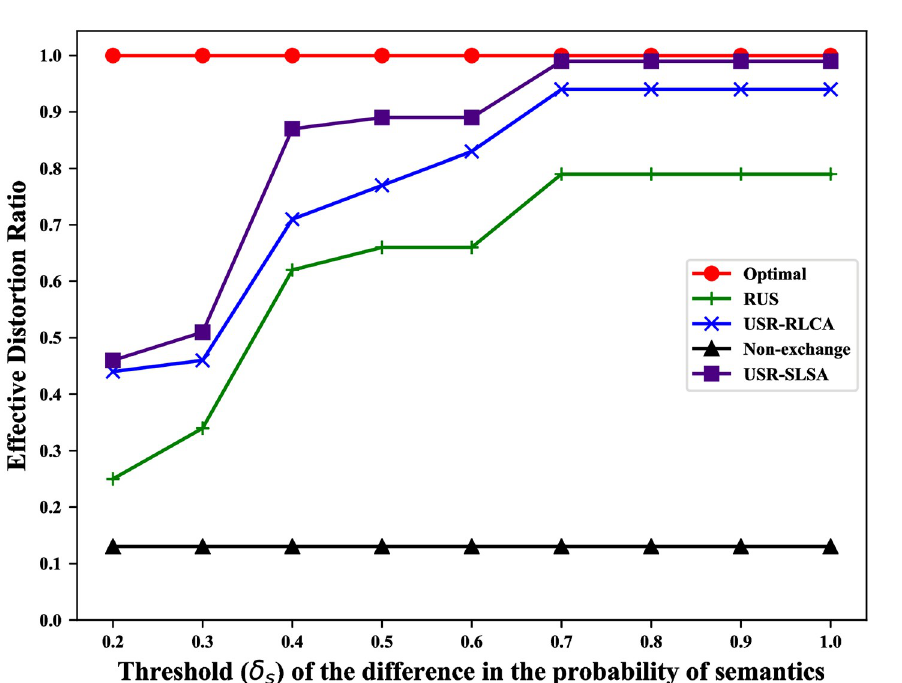
Fig 7. Impact of δ s on the privacy-preserving efficiency.